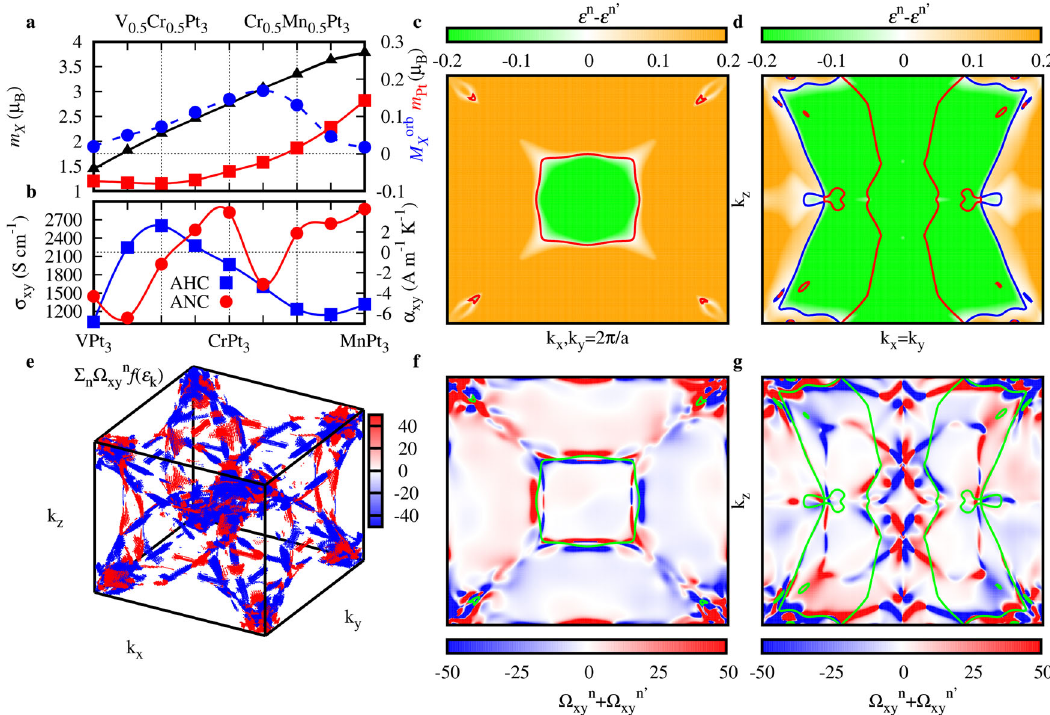
Fig. 3 Band analysis and Berry curvature from fi rst-principle calculations. a Magnetic moment m X (solid black triangles) and orbital moment X (dashed blue dots) ion in black and blue, respectively M orb X , and the magnetic moment of Pt m Pt (solid red squares) in red as a function of X ion concentration. b Anomalous Hall conductivity (AHC- σ xy ) in blue squares and anomalous Nernst conductivity (ANC- α xy ) at 300 K in red circles as a function of V, Cr, and Mn composition. c and d Spin-polarized band difference and nodal line of spin bands in the [100] and [110] plane, respectively. The band energy in the plane is de fi ned as ε n where orange is a positive difference, green is negative, and white displays differences <10 meV. The red and blue lines show differences in the two band energies <0.1 meV. c is plotted in the k y plane equal to 2 π / a whereas d is the plane for k x = k y . e 3D distribution of Berry curvature at the Fermi energy in the irreducible Brillouin zone here k x , k y , and k z are the reciprocal space vectors. Red and blue is the positive and negative Berry curvature in units of S cm − 1 . f and g 2D distribution of Berry curvature ( Ω xy ) of each spin – orbit coupled gapped band from the nodal line on the [100] and [110] plane, respectively. Green lines show the degenerate bands without spin – orbit coupling.